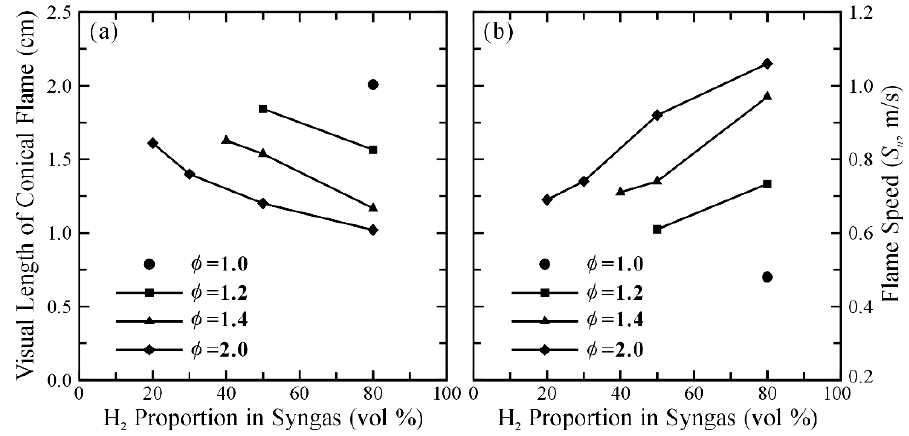
Figure 4. ( a ) Visual length of the conical flame and ( b ) calculated laminar flame speed of the stable CH 4 /syngas/air premixed impinging flame with varied H 2 /CO proportion. Table 2. Combination parameters of blended fuel at a constant volume flow rate V total = 11.78 L/min for typical flame patterns.